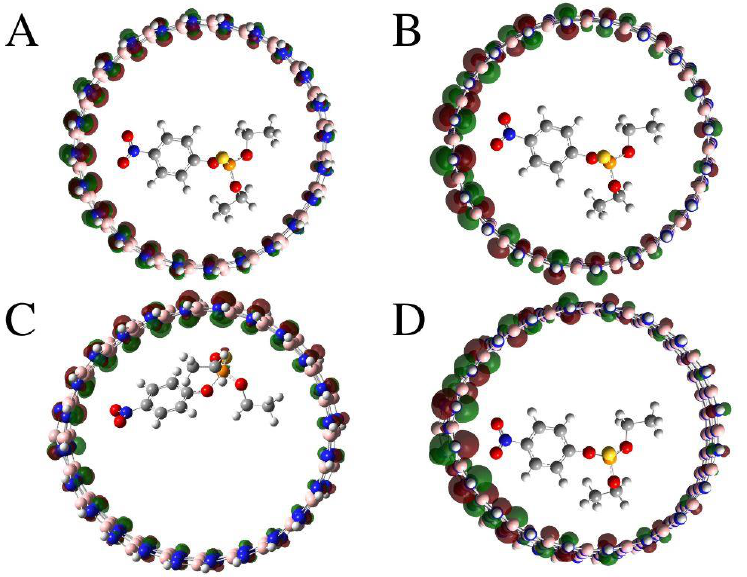
Figure 4. The HOMO diagrams of ( A ) BNNT(12,12) + par, ( B ) BNNT(20,0) + par, ( C ) Al-BNNT(12,12) + par, and ( D ) Al-BNNT(20,0) + par.